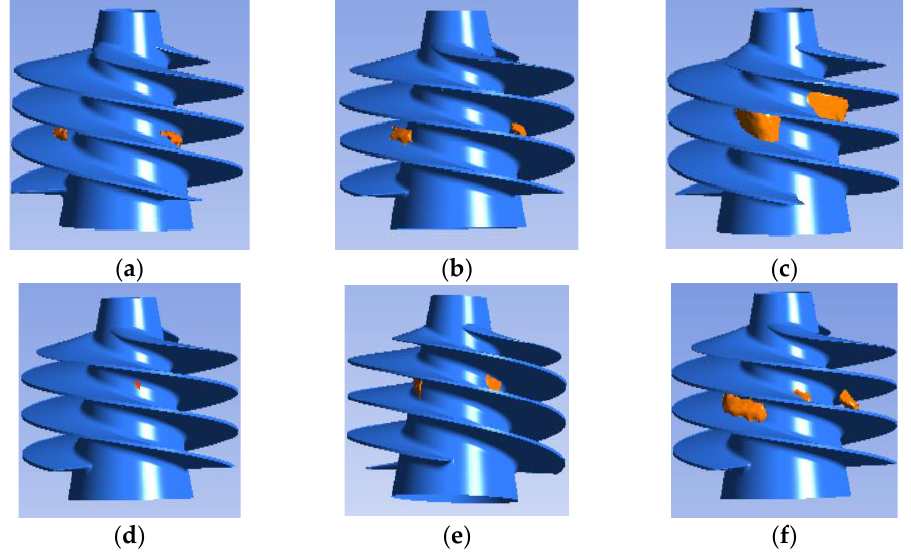
Figure 9. Iso-surface cloud diagram of the liquid water vapor volume fraction of two different Zwart models at three temperatures; ( a ) Iso-Zwart T = 298 K; ( b ) Iso-Zwart T = 320 K; ( c ) Iso-Zwart T = 350 K; ( d ) Mod-Zwart T = 298 K; ( e ) Mod-Zwart T = 320 K; ( f ) Mod-Zwart T = 350 K.